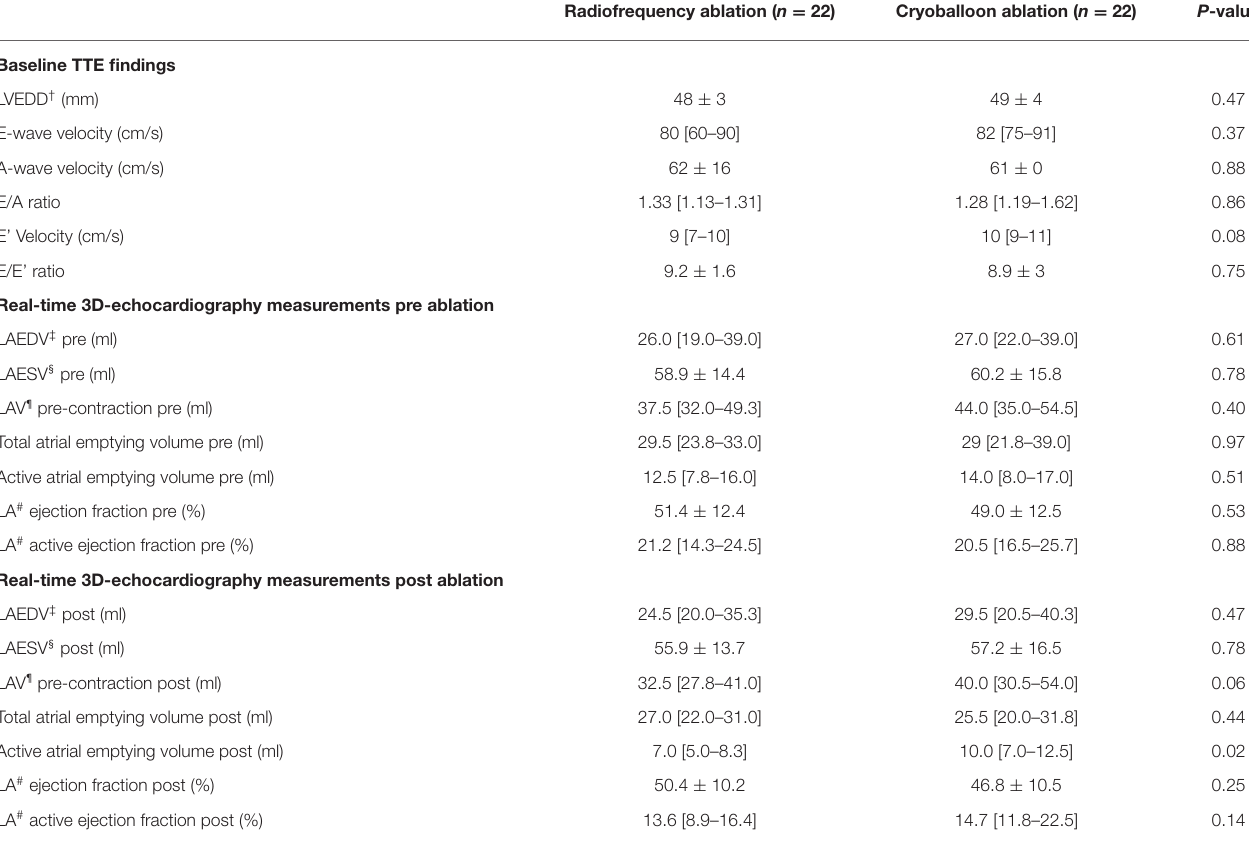
TABLE 3 | Echocardiographic characteristics by ablation